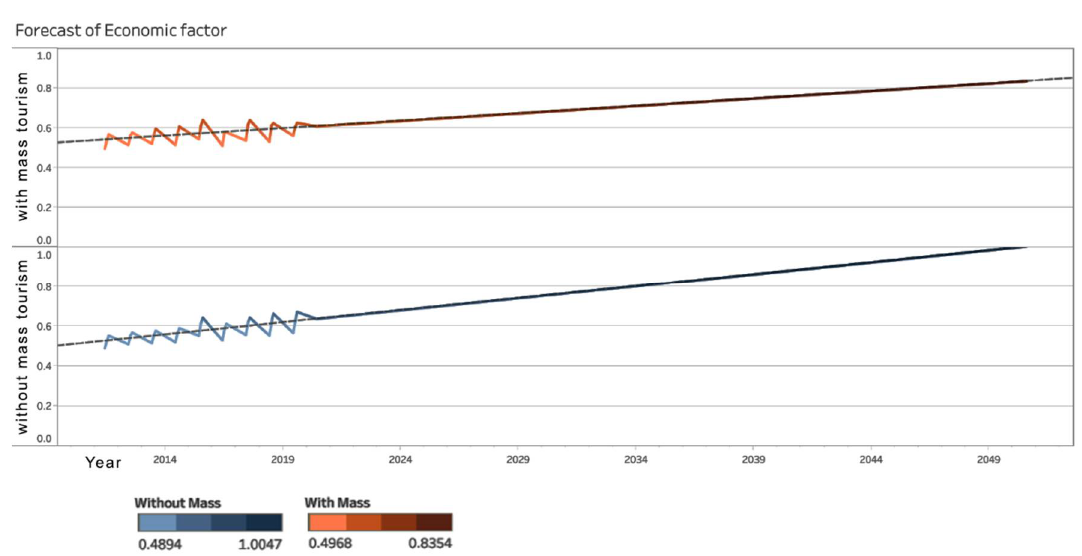
Figure 11. Analysis of economic factor average indicators for the two scenarios.